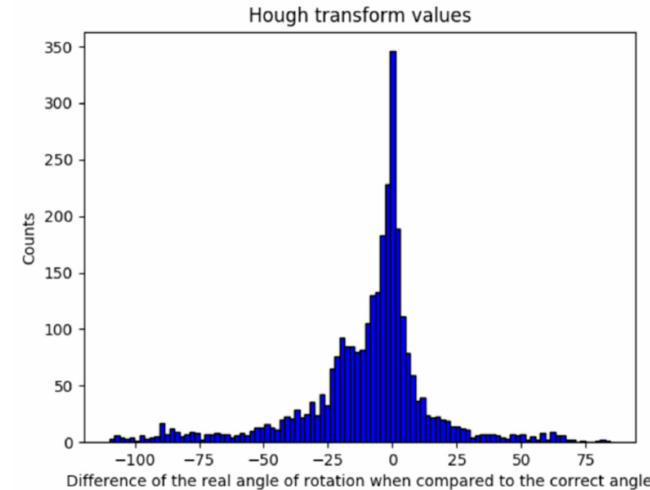
Figure 9. Error obtained by the implementation of Hough